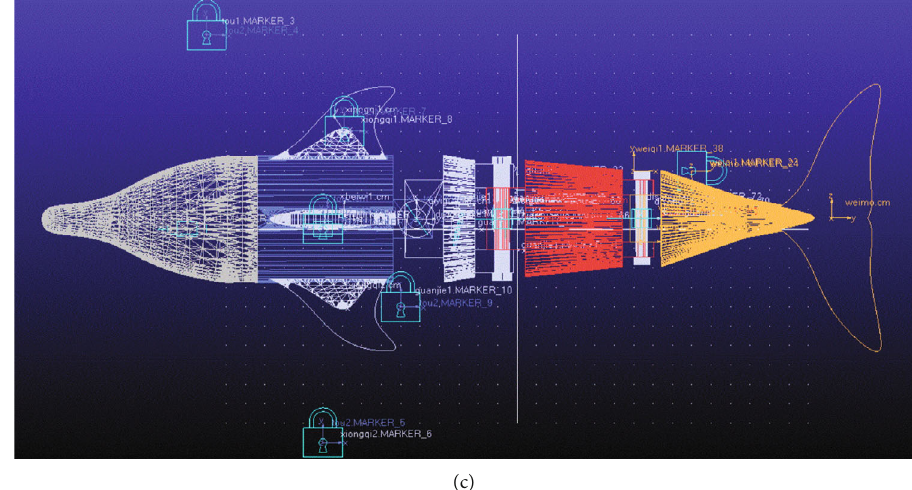
Figure 7: Diagram of motion simulation based on ADAMS. (a) Motion simulation of fl apping. (b) Displacement change of turning movement. (c) Overall dynamics mechanism design of robotic dolphin based on